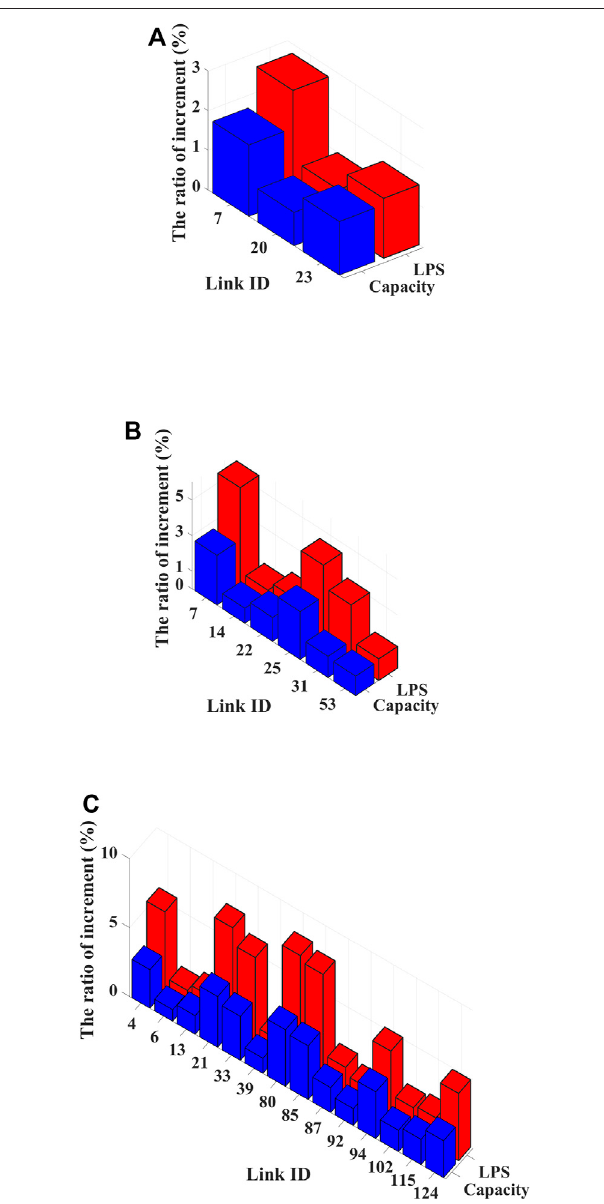
FIGURE 7 | The ratio of LPS improvement by increasing the capacity of each congestion link in (A) IEEE 39-Bus Case, (B) IEEE 57- Bus Case, and (C) IEEE 118-Bus Case. In each case, 30% of the nodes are removed from the network by random selection.